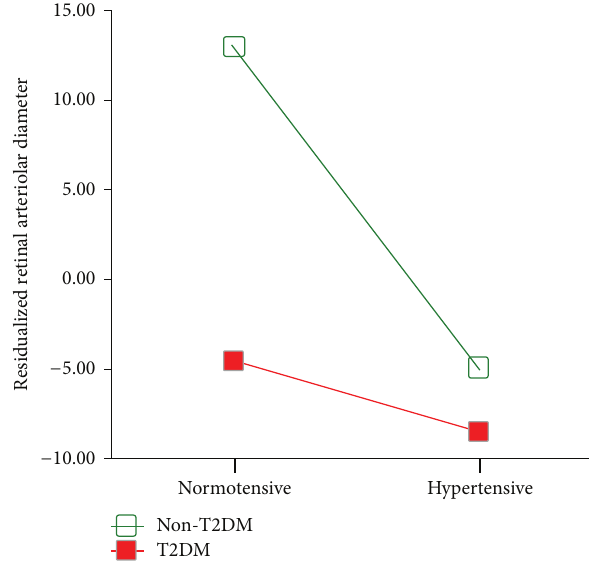
Figure 3: HTN × T2DM interaction effect on residualized retinal arteriolar diameter.